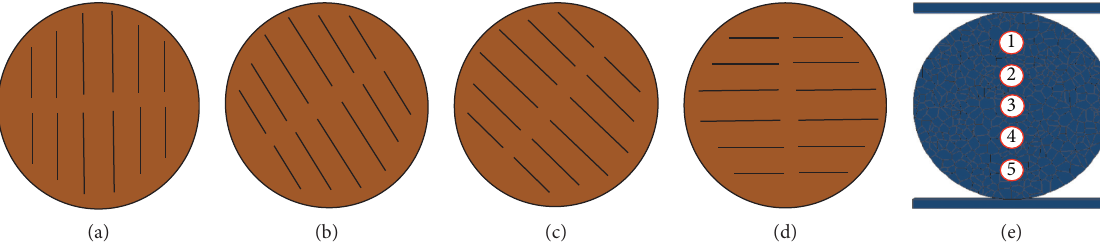
Figure 3: Schematic of preset bedding and observation points. (a) 0 ° . (b) 30 ° . (c) 60 ° . (d) 90 ° . (e) Observation